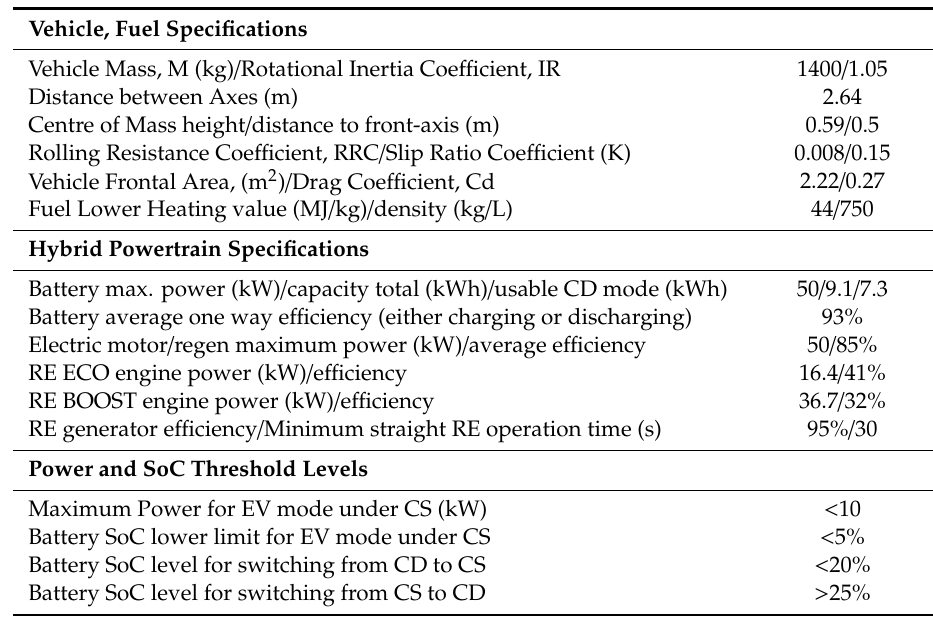
Table 2. Vehicle characteristics and modes of operation used in the driving cycle